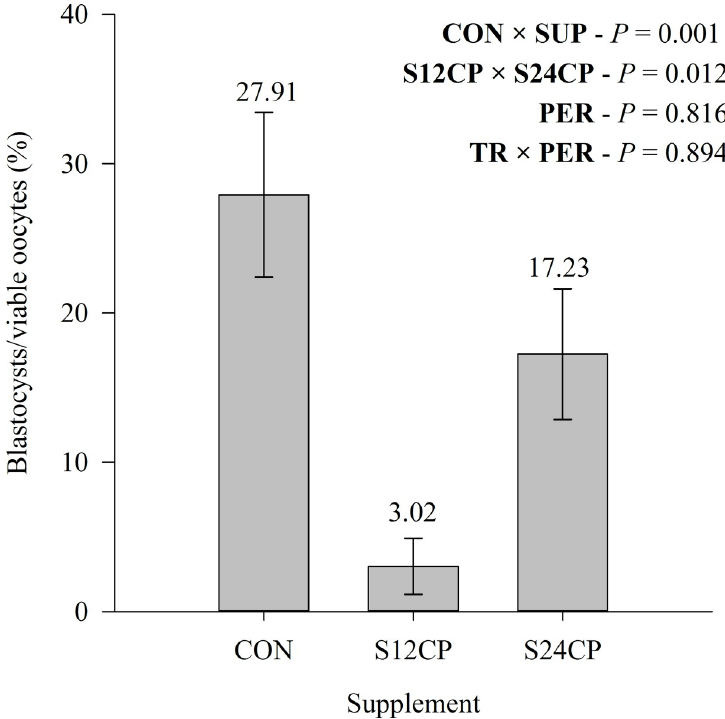
Fig 4. Blastocyst rate of Holstein x Gyr crossbred heifers on a rotational grazing system Panicum maximum cv. Mombac¸a pasture. � CON = not supplemented; S12CP: supplemented with concentrate containing 12% CP; S24CP: supplemented with concentrate containing 24% CP. � CON × SUP = effect of supplementation; S12CP × S24CP = effect of supplement protein levels; PER = effect of period; TR × PER = interaction effect between supplementation and